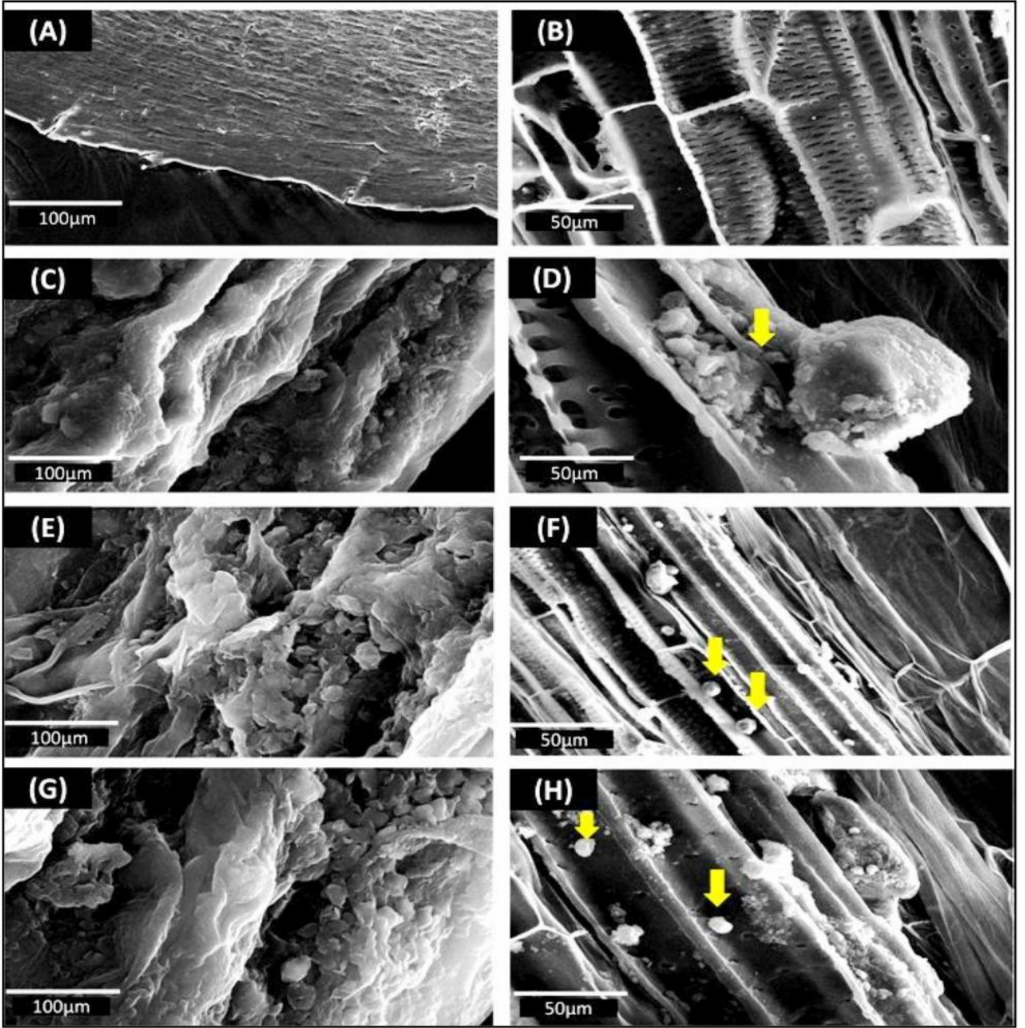
Figure 6. Scanning electron microscopic images of soybean seedling roots colonized by different endophytic bacteria under drought stress: ( A ) control uninoculated seedlings-at the root surface; ( B ) control uninoculated plant- root internal tissues; ( C ) AKAD A1-1- at the root surface; ( D ) AKAD A1-1—at the root internal tissue (yellow arrow); ( E ) AKAD A1-2—at the root surface; ( F ) AKAD A1-2—at the root internal tissue (yellow arrow); ( G ) AKAD A1-16—at the root surface ( H ) AKAD A1-16—at the root internal tissue (yellow